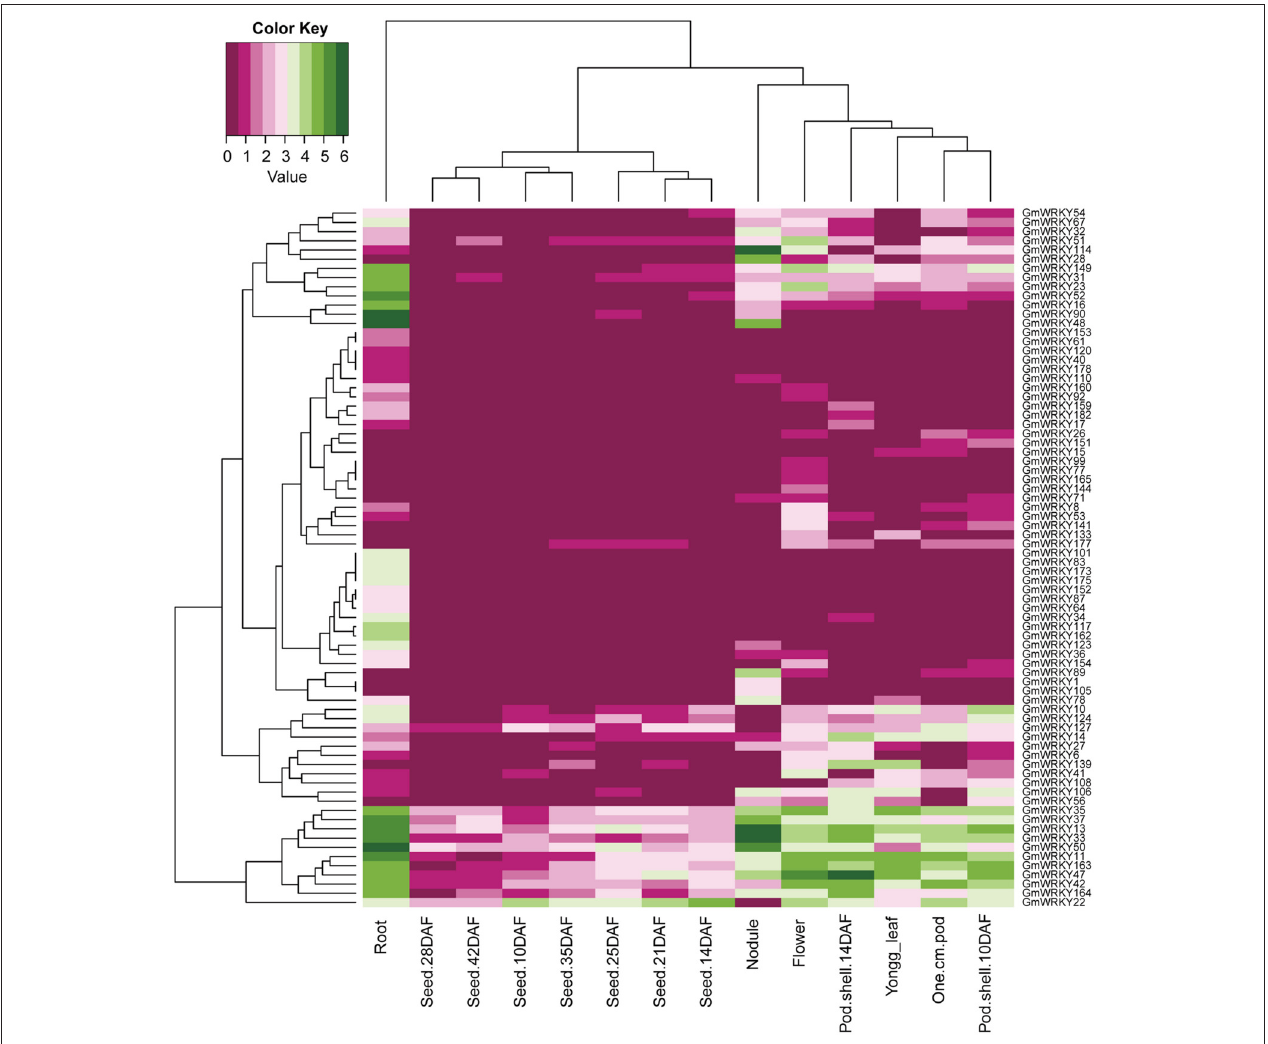
FIGURE 6 | Expression pattern of GmWRKY group II genes in different tissues. The Reads/Kb/Million (RPKM) normalized values of expressed genes was log 2 -transformed. The abbreviation “DAF” in the tissue label indicates “Days after